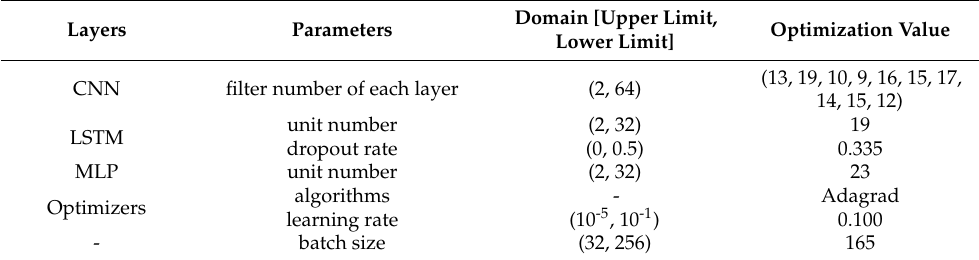
Table A1. The hyperparameters of the proposed model (direction along the river).